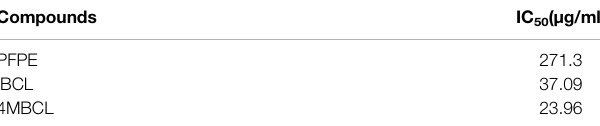
TABLE 3 | Cytotoxicity of PFPE, IBCL, and 4MBCL on Caco-2 cell line. Compounds